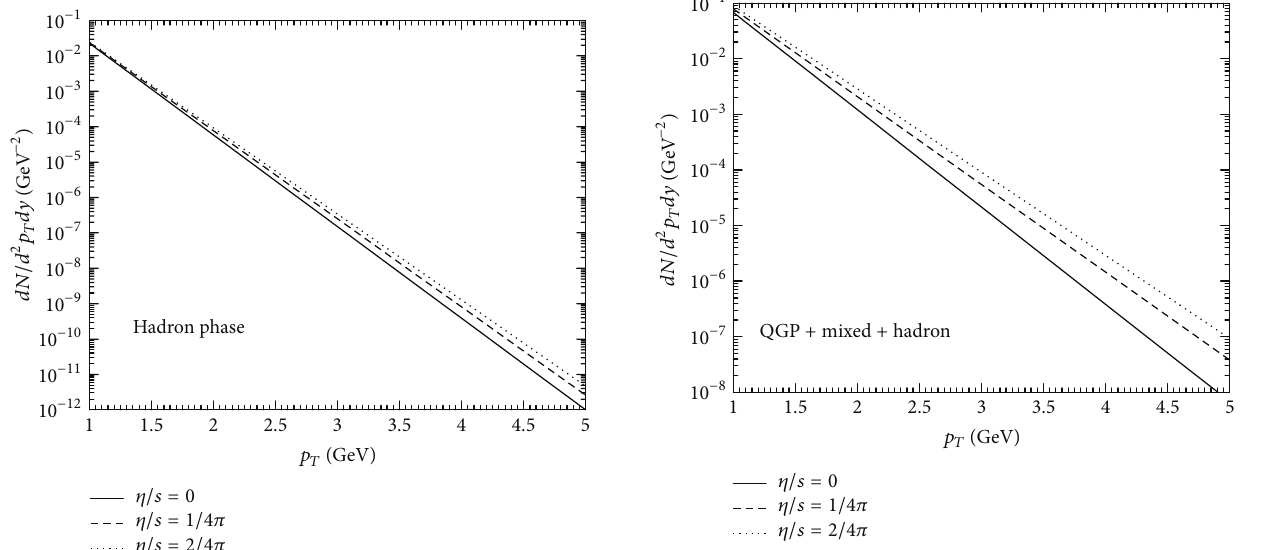
𝜂/𝑠 for scenario (i) and (ii), respectively. The effect of viscosity for the scenario (i) is stronger than